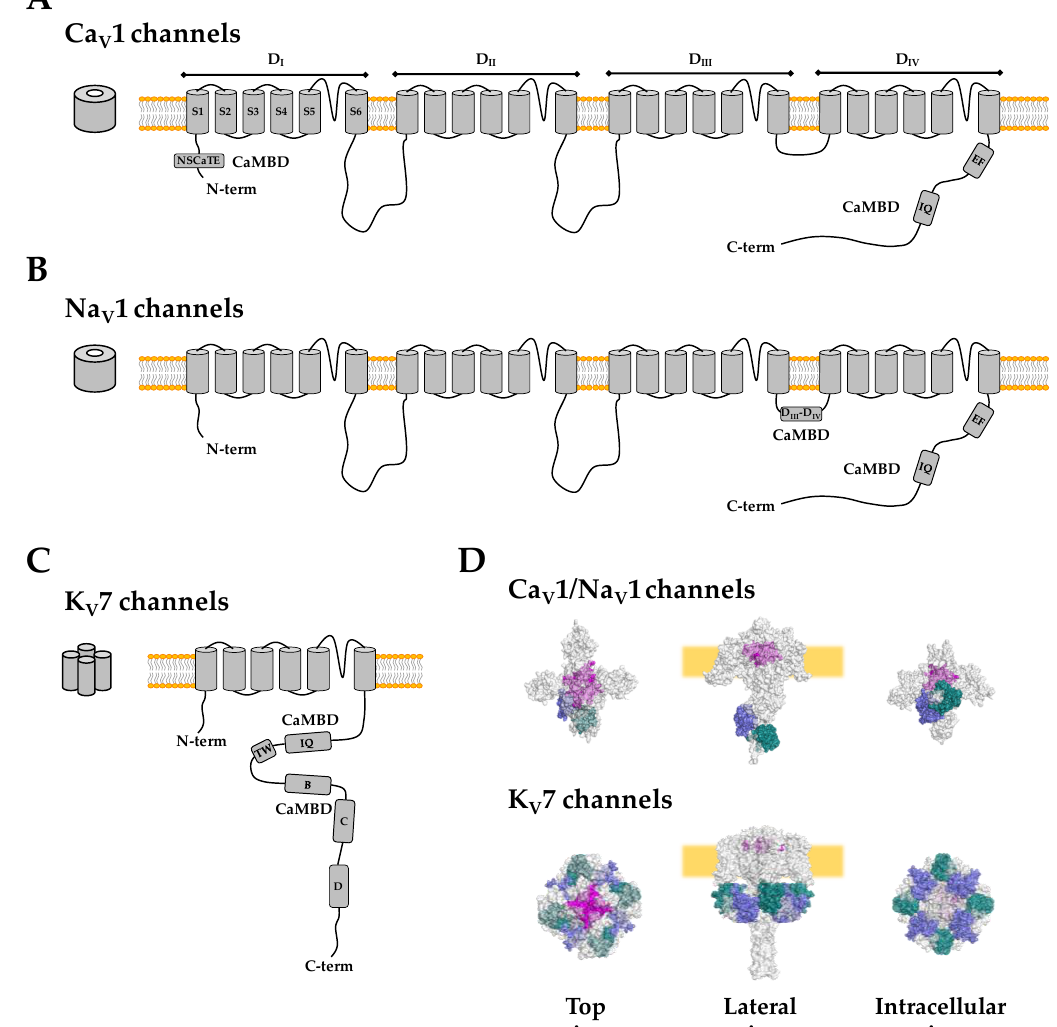
Figure 2. Topology of Ca V 1, Na V 1, and K V 7 channels. Schematic representation of Ca V 1 ( A ), Na V 1 ( B ), and K V 7 ( C ) channels. The functional assemblies are schematically represented on the left side. Note that Ca V 1 and Na V 1 channels are composed of four repeats within a single polypeptide, while four subunits are needed to form K V 7 channels. Homologous repeat domains (D I –D IV ); transmembrane segments (S1–S6); N-terminal spatial Ca 2+ transforming element (NSCaTE), CaM Binding Domain (CaMBD), IQ motif, EF-hands, TW helix, helix B, helix C, and helix D are labeled. ( D ) Composite 3D structures of Ca V 1/Na V 1 channels (top panel; combining PDBs: 5GJW and 4DCK) and K V 7 channels (bottom panel; PDBs: 5VMS and 3BJ4). The pore forming domain is colored in magenta, the CaM N-lobe in blue and C-lobe in green. Transparency was set to 40%, allowing the view of CaM from the top, and the pore from a lateral perspective. Note that in the presence of Ca 2+ , the N-lobe of CaM should be near the N-terminal of the Ca V channels or the D III –D IV linker for Na V channels after activation (not shown). The auxiliary β subunits are not shown. Pymol 1.5 was used to render panel D.